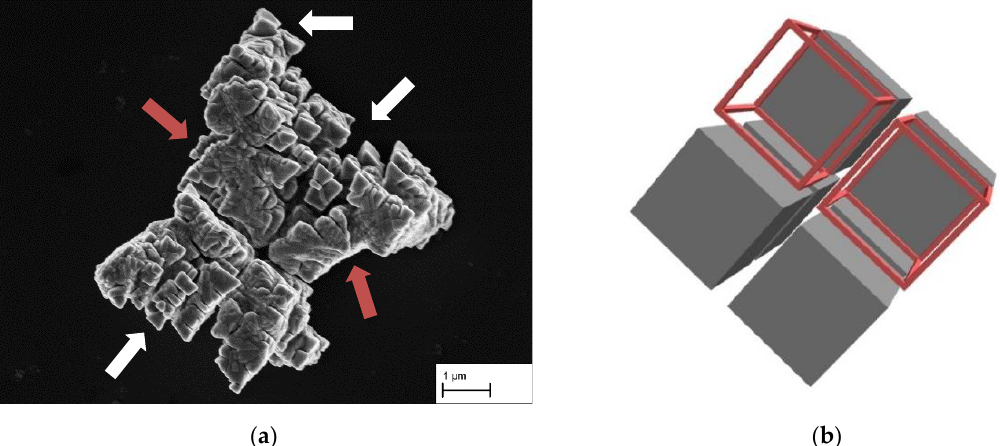
Figure 5. ( a ) Extracted γ’ -particle from the specimen cooled to 950 °C. Fine, coherent cubes in the outer regions (white arrows). Semi-coherent interfaces in the center (splitting channel of the original cube; red arrows). ( b ) Schematic representation of the particle, red-framed parts are no longer present on the left, giving a clear view of the central γ -channel.